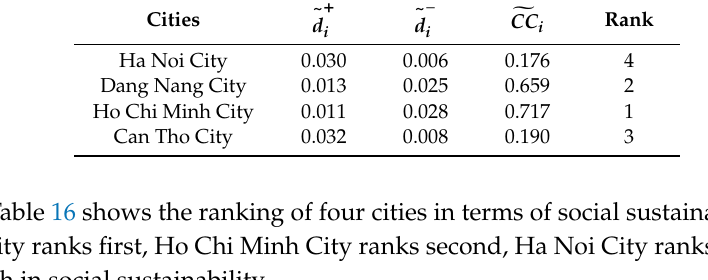
Table 15. Closeness coe ffi cients and rank of alternatives for economic sustainability. Cities